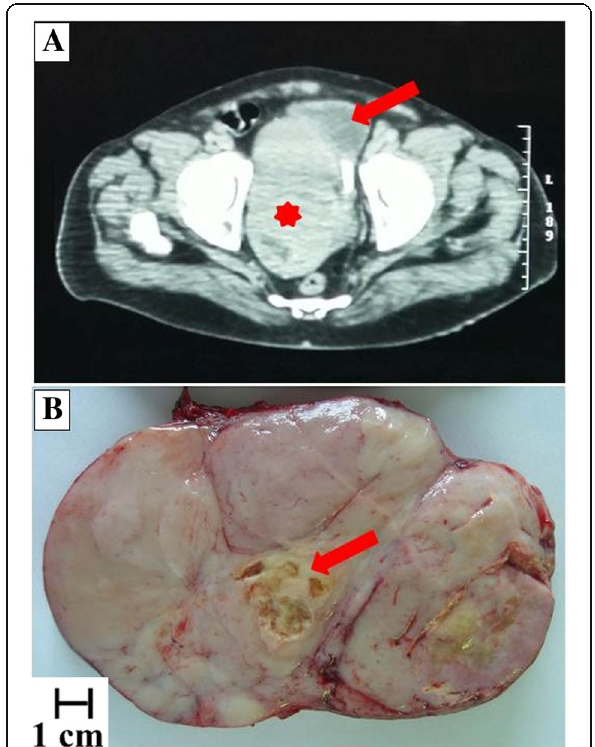
Fig. 1 Computed Tomography and macroscopic features of the neoplasm. a Computed tomography showed a large, well defined mass compressing urinary bladder ( asterisk marks the prostatic mass; arrow marks the urinary bladder); b Gross appearance of the surgical specimen showing lobulated, well defined and whitish mass with central area of necrosis ( arrow